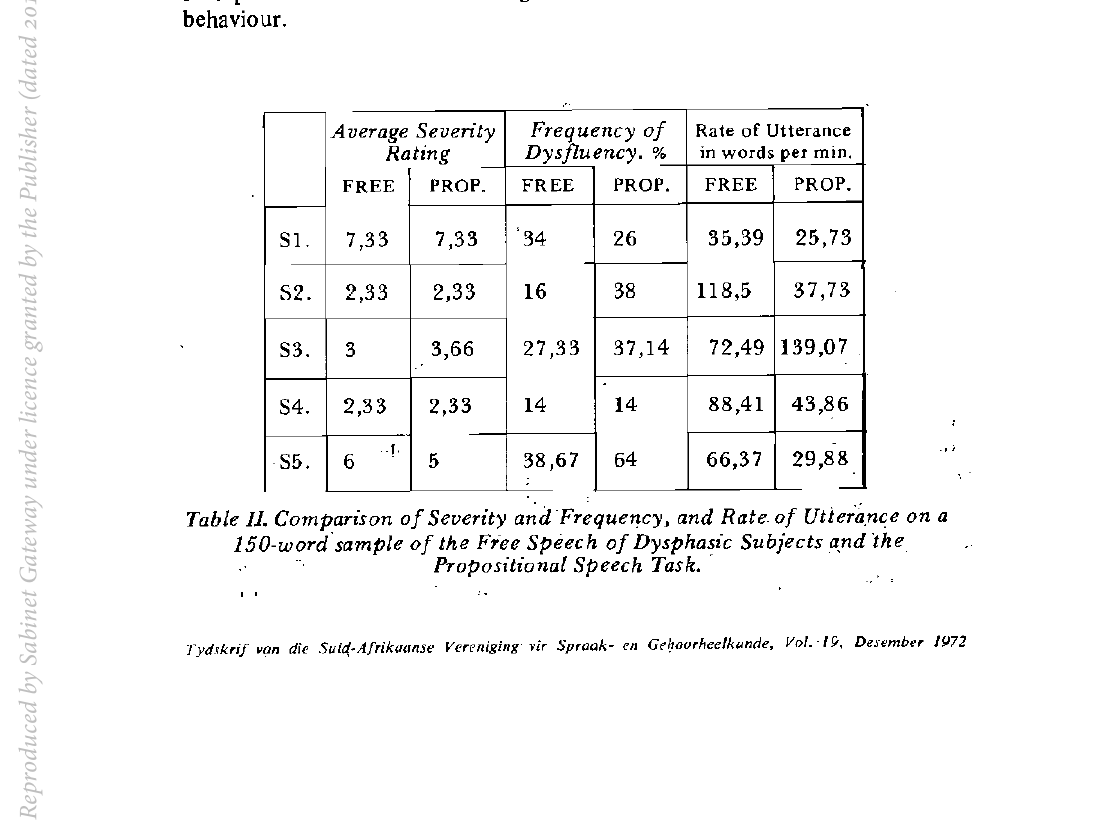
Tydskrif van die Suid-Afrikaanse Vereniging· vir Spraak- en Gehoorheelkunde. Vol. 19, Desember